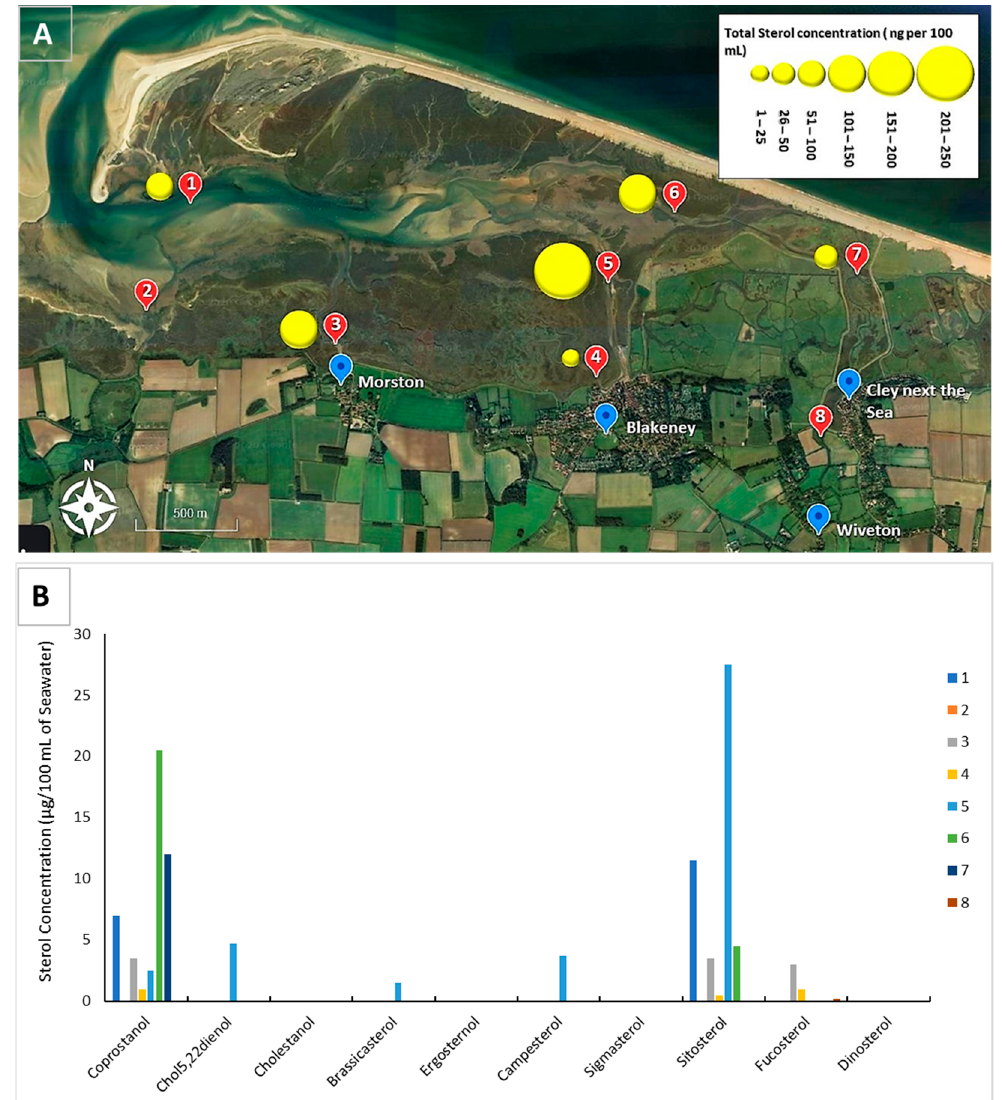
Figure 3. ( A ). Total water sterol concentrations of at each of the sites. Concentrations (ng per 100 mL of seawater) are given in ranges and are indicated by the different sized symbols and are indicated by the different sized symbols. (1) Simpoles Head, (2) Freshers Creek, (3) Mortson Creek, (4) Blakeney Harbour, (5) Blakeney Harbour Sluice, (6) Scaupe Run, (7) River Cley (below weir), (8) River Cley (above weir). ( B ) Relative concentrations of sterols in water samples taken from around Blakeney Point during a low tide period with omission of